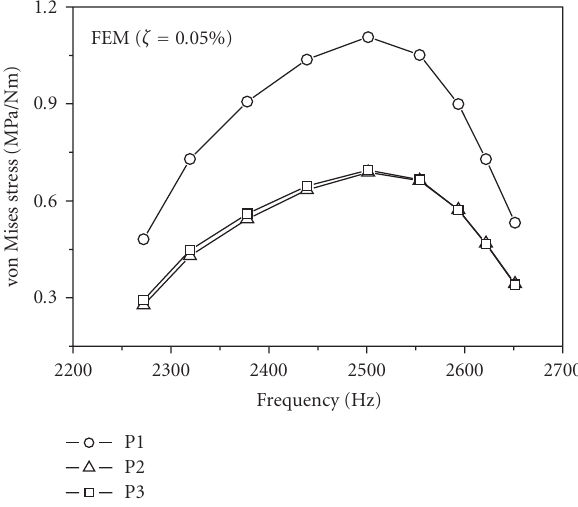
Figure 11: Blade stress excited by torsional excitation.